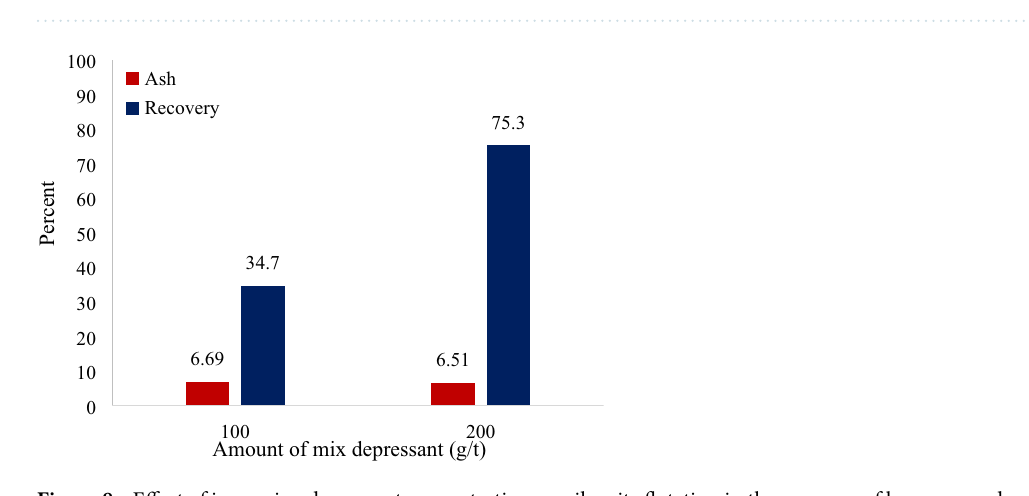
Figure 7. Recovery and ash content of gilsonite flotation concentrate ( a ) in the presence and absence of the depressants (without collector and frother), ( b ) in the use of different dosage of a depressant (absence of collector and frother).